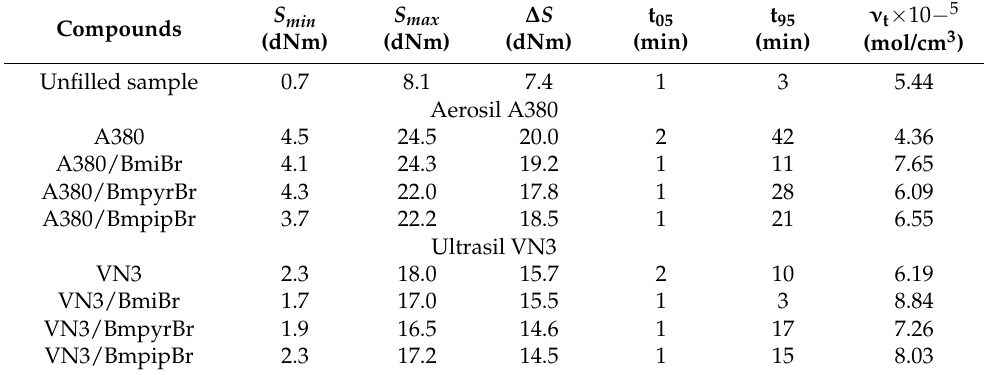
Table 4. Cure characteristics at 160 ◦ C of SBR compounds filled with A380 and VN3 silica and crosslink density of vulcanizates ( S min , minimum torque; S max , maximum torque; ∆ S , torque in- crease; t 05 , scorch time; t 95 , optimal vulcanization time; standard deviations: S min ± 0.3